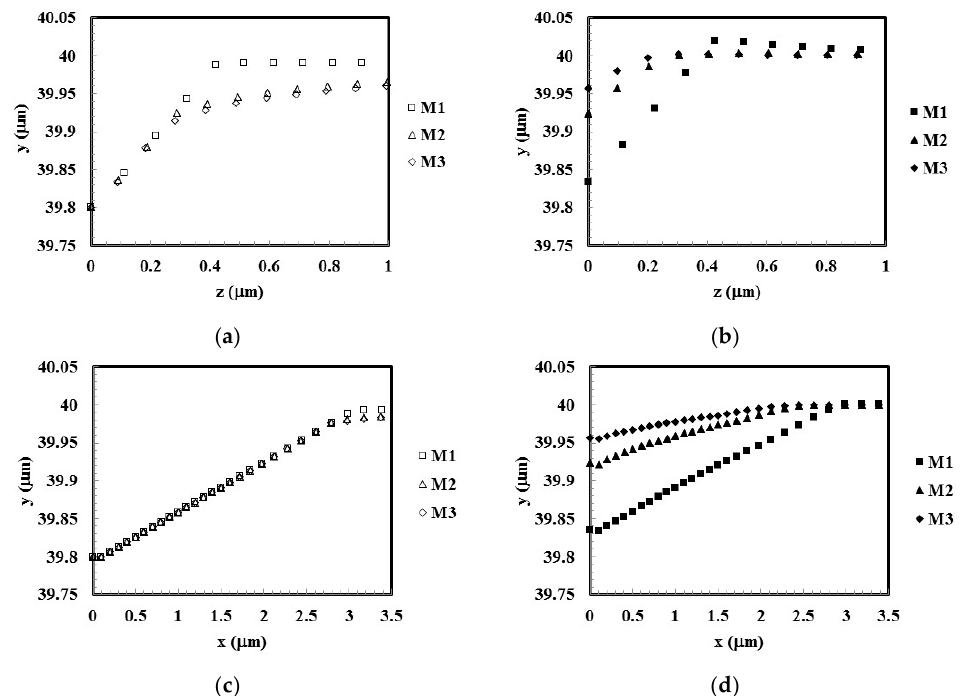
Figure 5. Surface indentation profiles obtained along the two diagonals, the shorter, m ( z -axis) and the longer, L ( x -axis), respectively: ( a , c ) obtained at maximum load; ( b , d ) after unloading. After unloading, the indentation profiles corresponding to the materials M2 and M3 shown elastic recovery in both diagonals (Figure 5b,d). Moreover, the amount of elastic recover increases with the decrease of the ratio ℎ (cid:2916) /ℎ (cid:2923)(cid:2911)(cid:2934) . In case of M1 material, with a ratio ℎ (cid:2916) /ℎ (cid:2923)(cid:2911)(cid:2934) = 0.97 and without strain hardening, the indentation profile along the short diagonal shows pile-up (Figure 5b). In fact, for other indenter geometries (conical and Vickers), the pile-up appears for values of the ratio ℎ (cid:2916) /ℎ (cid:2923)(cid:2911)(cid:2934) higher than 0.8 in materials without strain hardening (see, e.g., [22,30]). It should be noted that, for a given material, the ℎ (cid:2916) /ℎ (cid:2923)(cid:2911)(cid:2934) ratio correlates with the value of the H /𝐸 ratio between the hardness and the